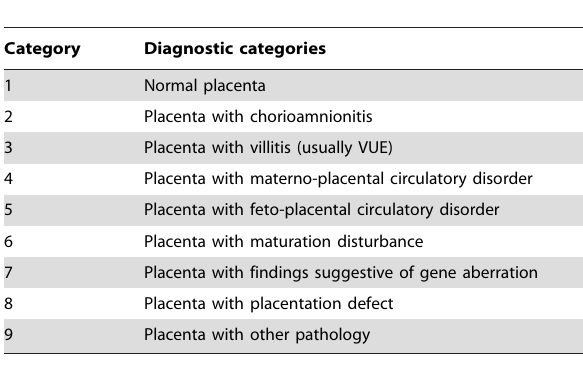
Table 1. A systematic and standardized classification of placental pathology